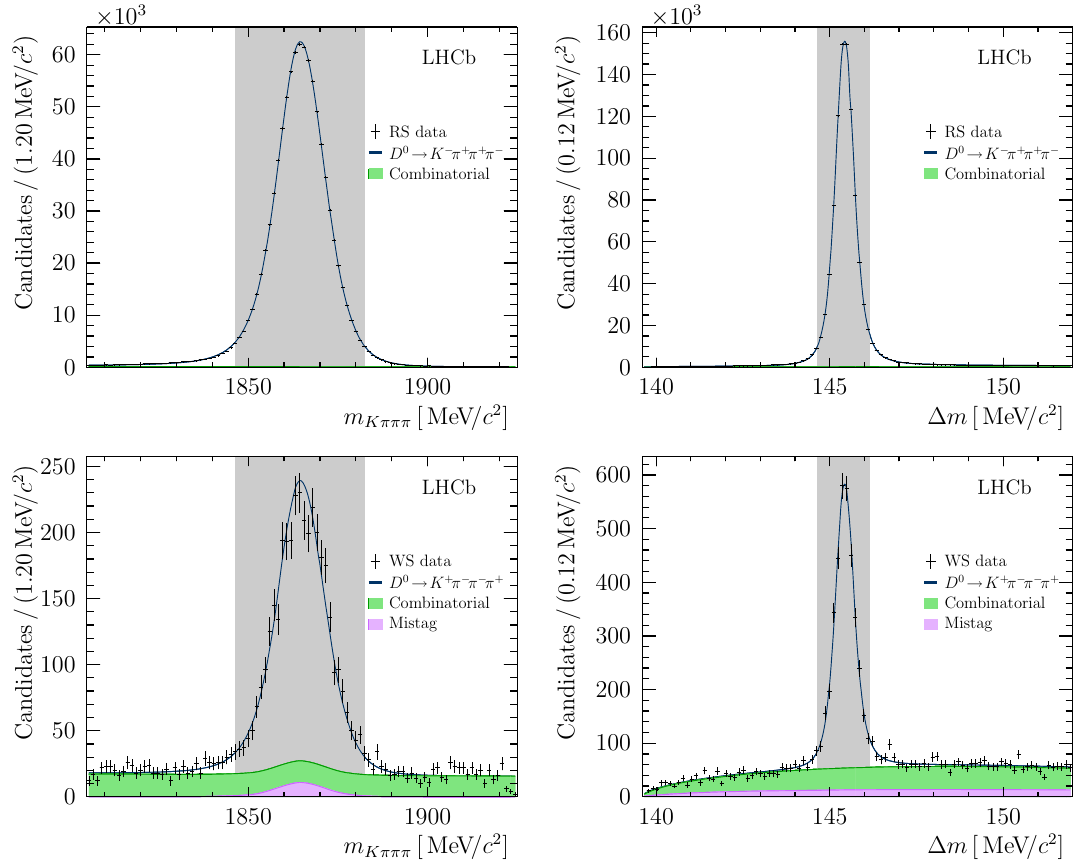
Fig. 1 Invariant mass and mass difference distributions for RS (top) and WS (bottom) samples, shown with fit projections. The signal region is indicated by the filled grey area, and for each plot the mass window in the orthogonal projection is applied